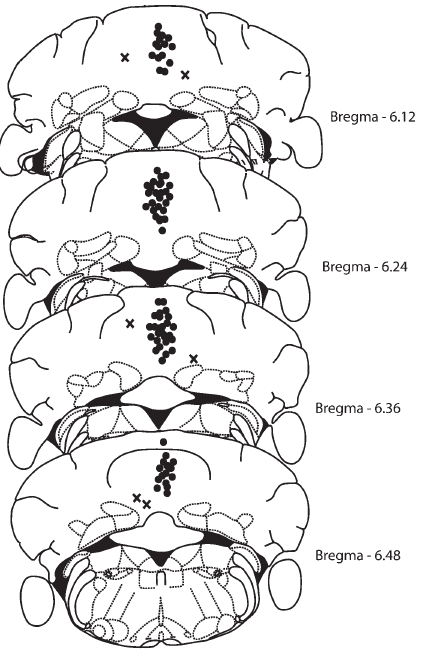
Figure 1. Schematic representation adapted from Franklin and Paxinos (12) of sites of microinfusion into the cerebellum of mice. The points represent correct site injections (the number of points is smaller than the total number of mice because of